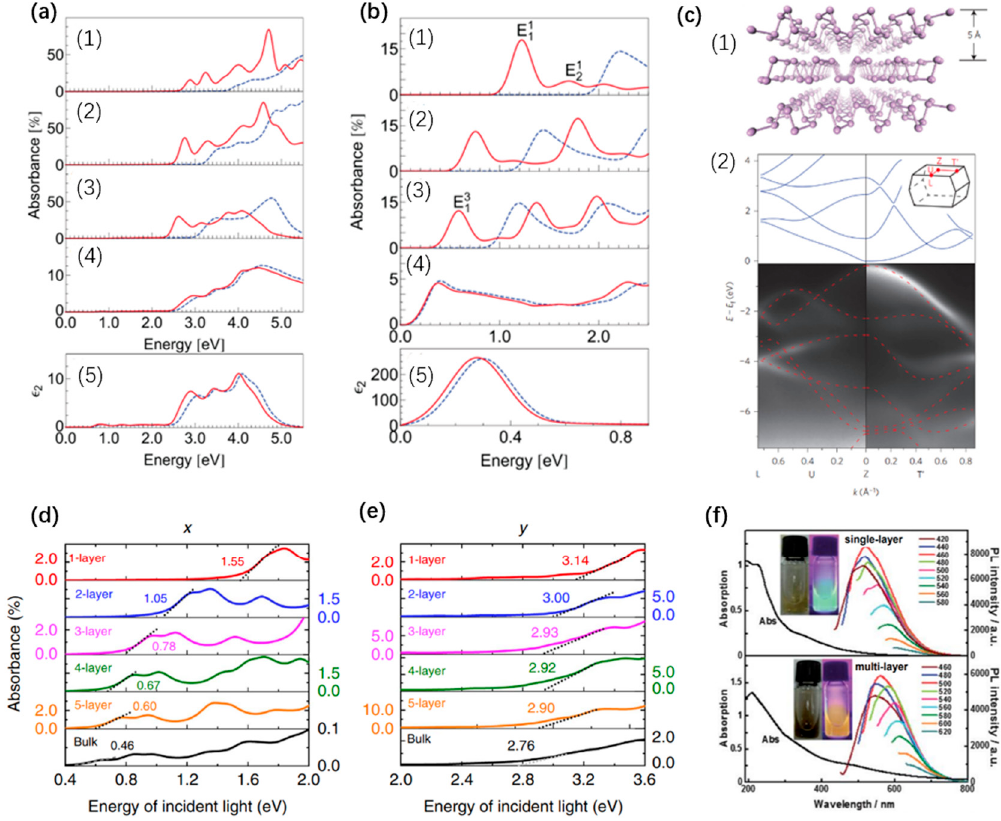
Figure 9. ( a ) Absorption spectra of monolayer (1), bilayer (2), trilayer (3), and bulk phosphorene [(4) and (5)] for the incident light polarized along the x (armchair) direction. Reprinted with permission from Ref. [135]. Copyright 2014 American Physical Society. ( b ) Optical absorption spectra of monolayer (1), bilayer (2), trilayer (3), and bulk phosphorene [(4) and (5)] for the incident light polarized along the x (armchair) direction. Reprinted with permission from Ref. [135]. Copyright 2014 American Physical Society. ( c ) Crystal and electronic structure of bulk black phosphorus. (1) Atomic structure of black phosphorus. (2) Band structure of bulk black phosphorus. Reprinted with permission from Ref. [134]. Copyright 2014 Springer Nature. ( d , e ) Optical absorption spectra of few-layer BP for light incidents in the c (z) direction and polarized along the a (x) and b (y) directions. Reprinted with permission from Ref. [136]. Copyright 2014 Springer Nature. ( f ) UV-vis absorption and PL emission spectra of GQDs1 and GQDs2 in water solution. Reprinted with permission from Ref. [131]. Copyright 2012 ROYAL SOCIETY OF CHEMISTRY.